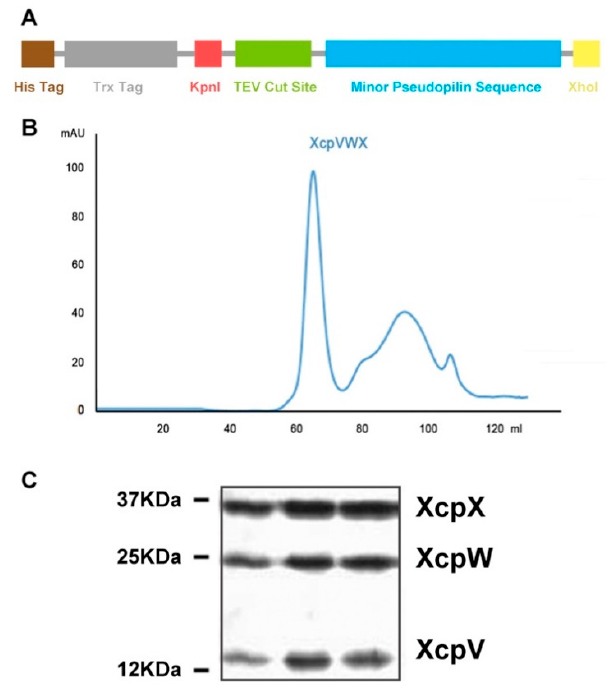
Figure 1. Purification of the XcpVWX ternary complex. ( A ) Schematic of the clone structure of the minor pseudopilins. The sequence of the minor pseudopilin follows the TEV cut site to generate a soluble tag-free form of pseudopilins. ( B ) Purification of the XcpVWX ternary complex through size exclusion chromatography (SEC). The complex peak elutes at 60 mL on a Superdex 75 Hiload gel filtration column. ( C ) SDS-PAGE result of the fractionated peak eluate reveals the formation of the ternary complex by the three pseudopilin molecules.